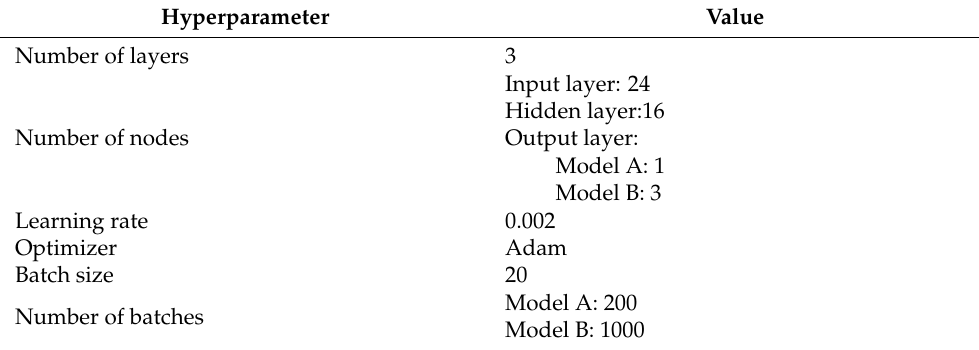
Table 3. Severity levels predicted by the model. Table 4. MLP model